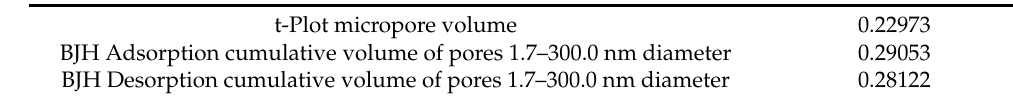
Table 2. Pore volume (cm 3 /g) characterization of activated carbon.